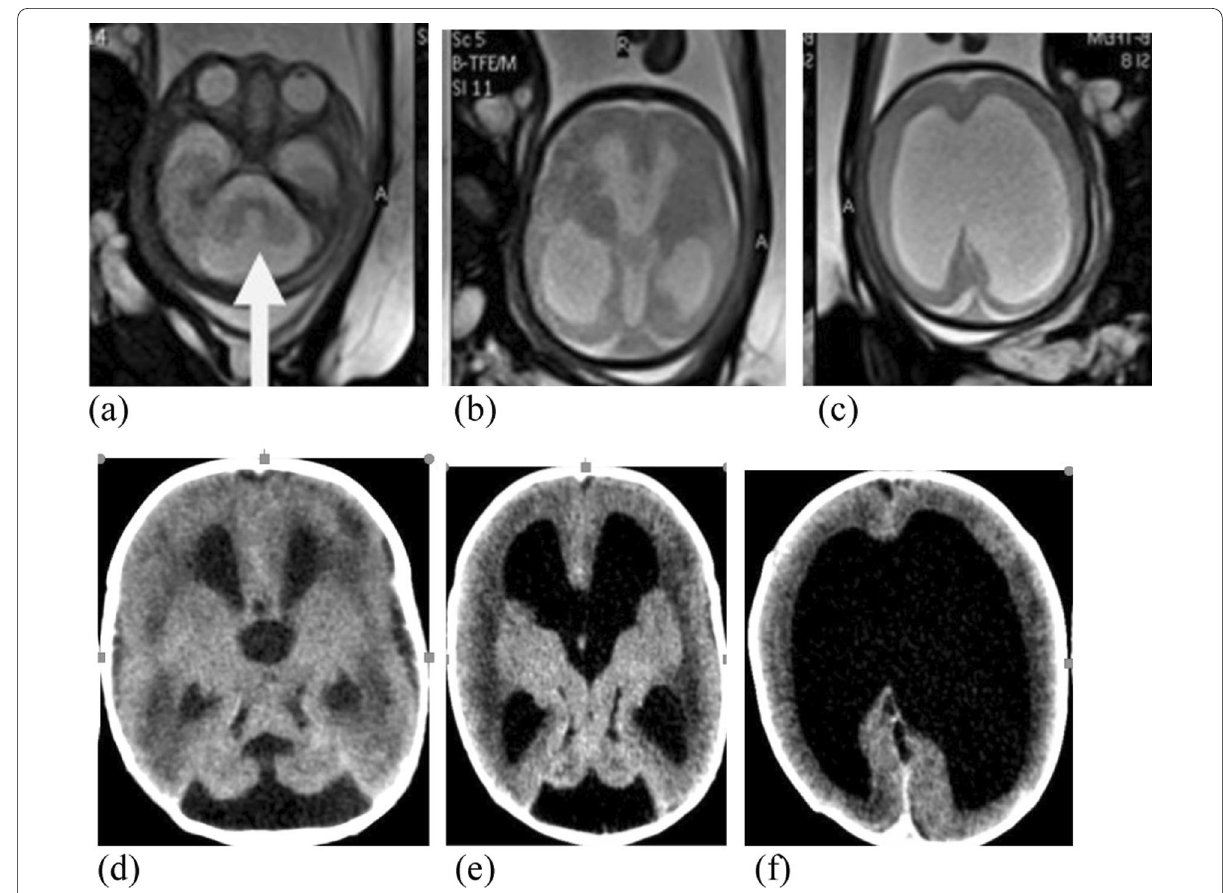
Fig. 5 Twenty-nine-week gestation; SSFSE T2WIs axial planes at the level of posterior fossa and lateral ventricle revealed hypoplastic vermis with dilated fourth ventricle which is seen communicating with the enlarged retro-cerebellar CSF space ( a ); associated supratentorial hydrocephalus ( b , c ). MRI diagnosis: Dandy–Walker malformation. Recommendation: Postnatal shunting. Postnatal CT images ( d – f ), confirmed the same diagnosis of DWM